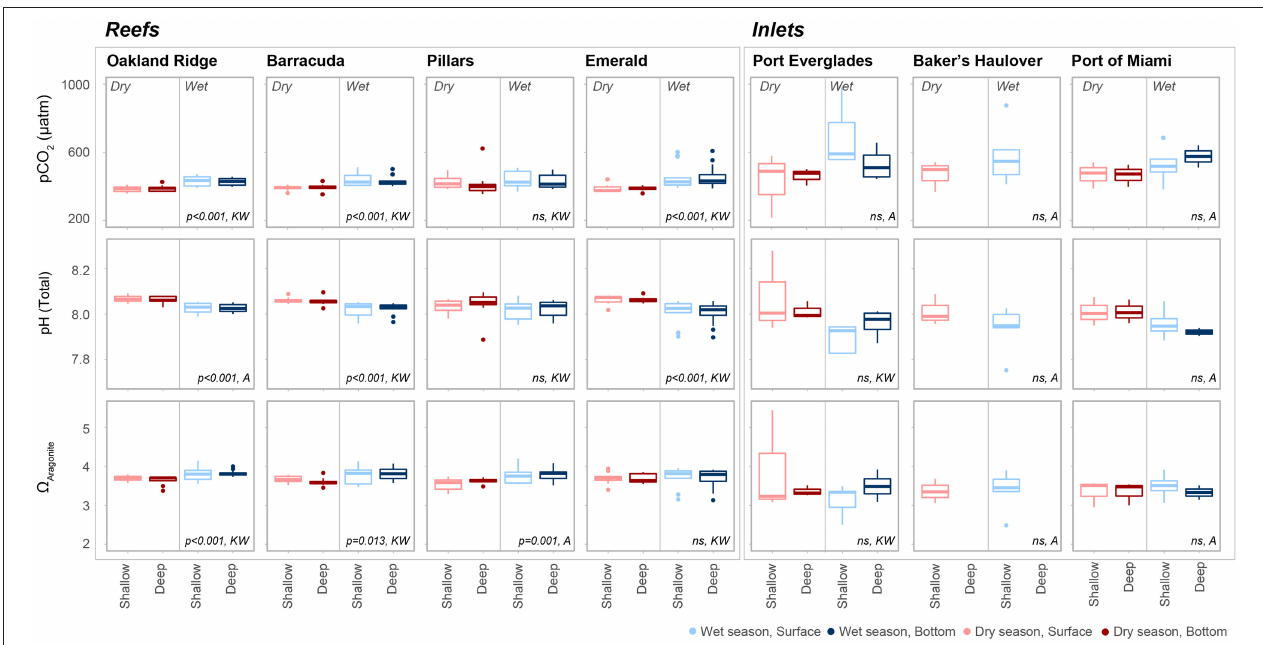
FIGURE 6 | The partial pressure of carbon dioxide (pCO 2 , µ atm), pH (Total scale), and aragonite saturation state ( (cid:127) Arag. ) at each of four reef and three inlet sampling sites. Data are divided into dry (red) and wet season (blue). Darker colors represent samples taken above the benthos while lighter colors represent samples taken at the surface. P values are given for significant differences as determined by ANOVA (A) or nonparametric Kruskal-Wallis (KW) tests. Non-significant ( p > 0.05) are marked ns.